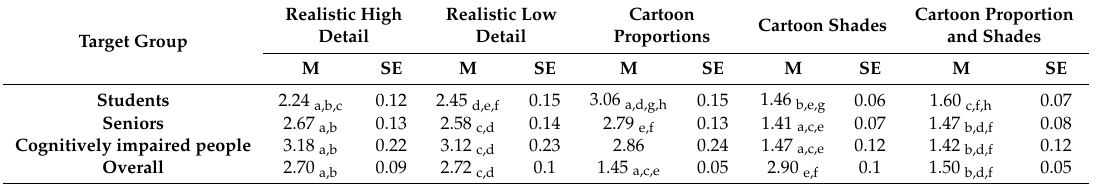
Table 3. Uncanniness ratings for agents’ degrees of realism of all target